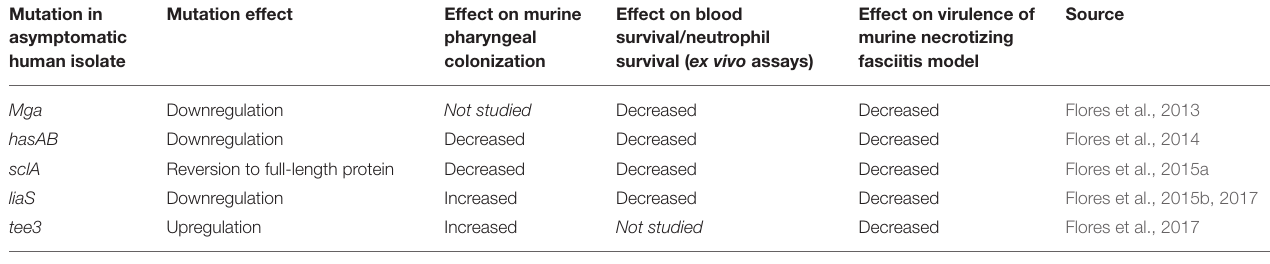
TABLE 1 | Comparison of asymptomatic isolates and their behavior in various in vitro and in vivo models. Mutation in asymptomatic